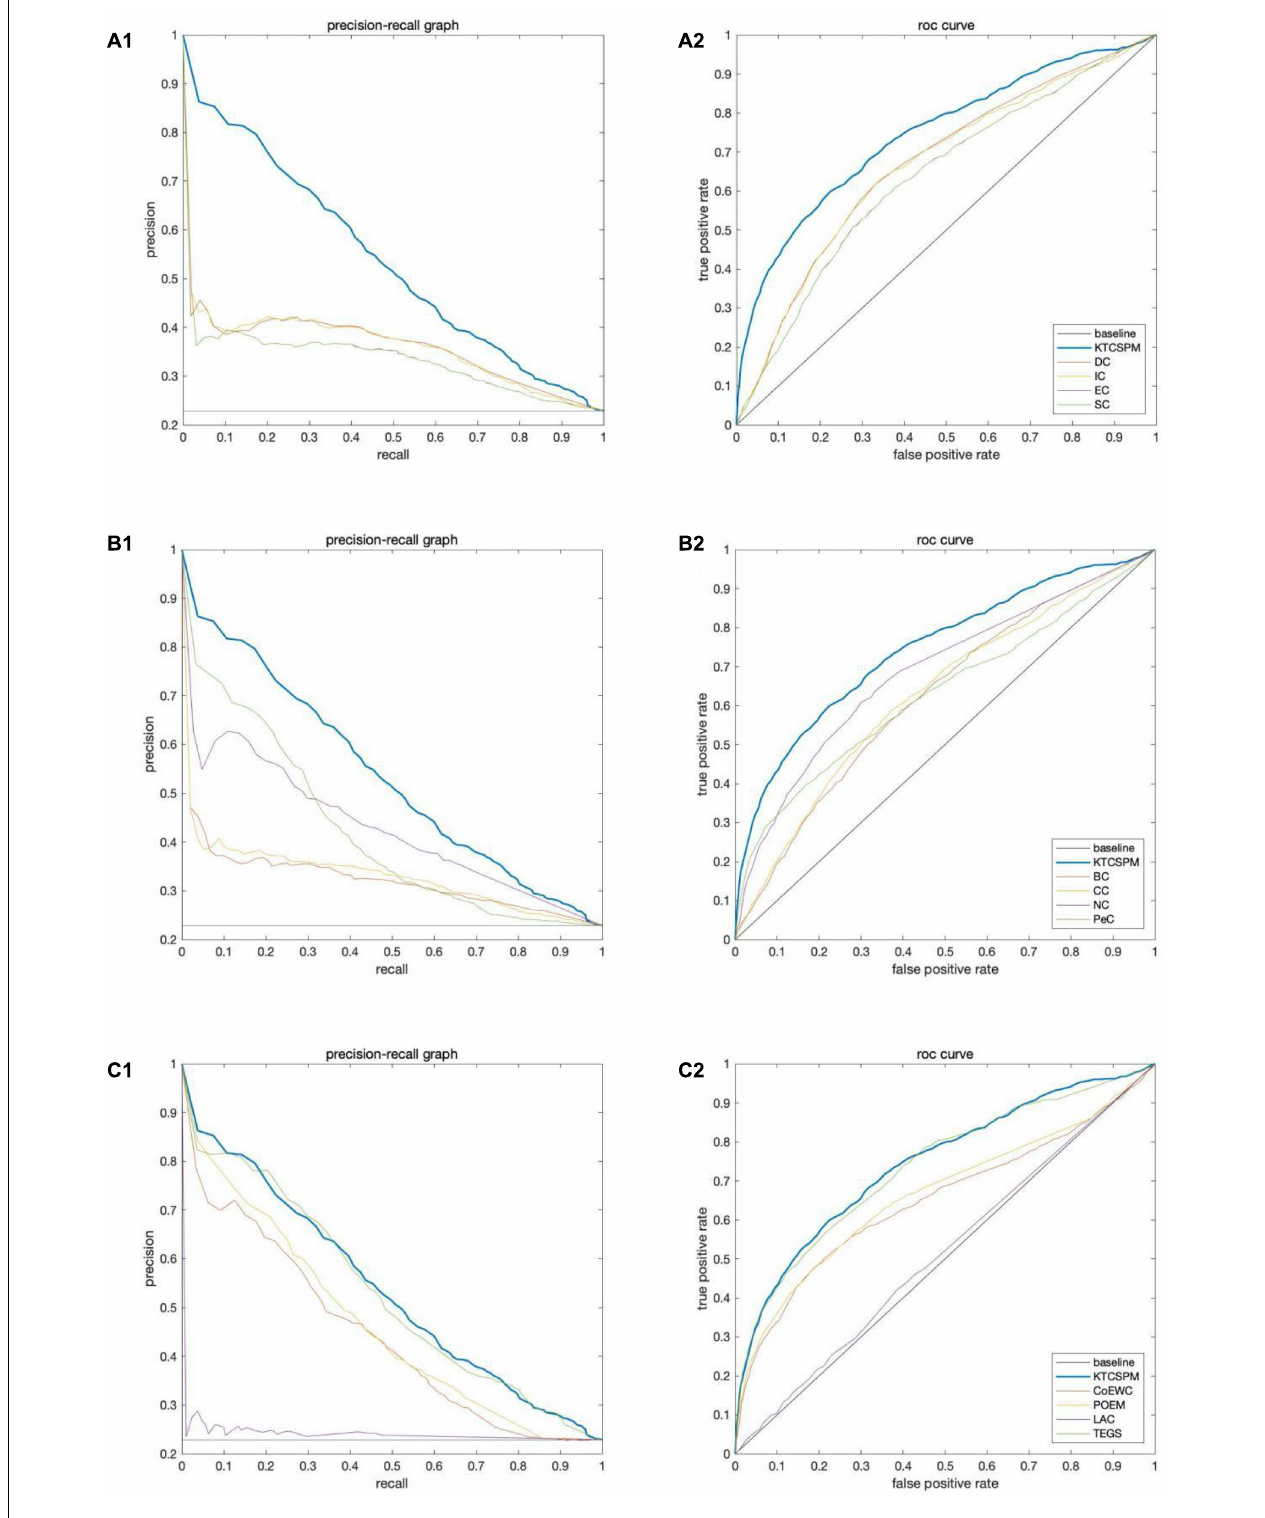
FIGURE 5 | Comparisons of performance between key target convergence sets based prediction model (KTCSPM) and 12 competitive models under the PR curve and ROC curve based on the DIP database. Panels (A1–C1) are comparison results of PR curves between KTCSPM and 12 competitive models. Panels (A2–C2) are comparison results of ROC curves between KTCSPM and 12 competitive